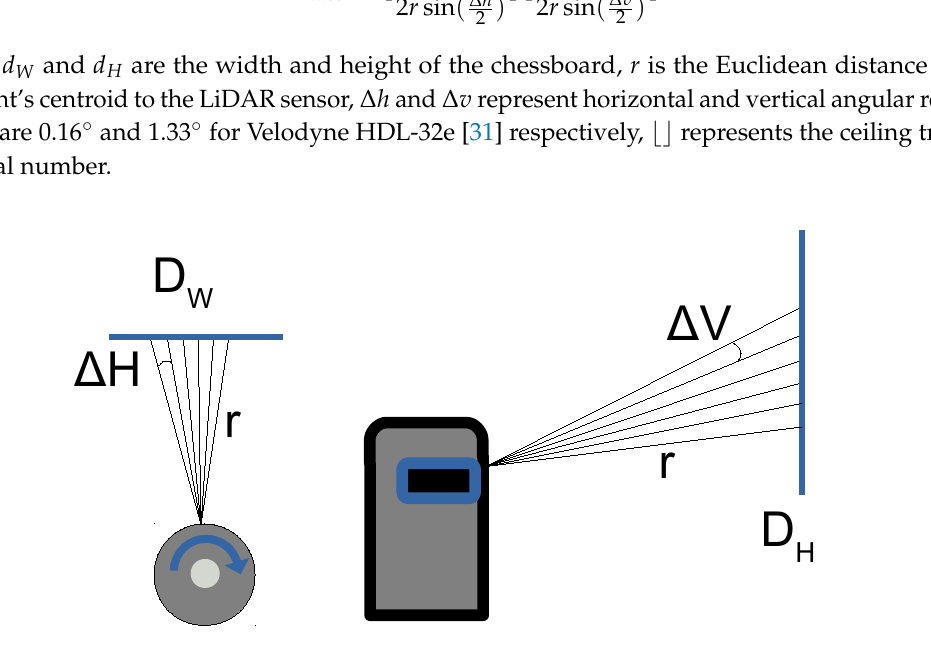
Figure 3. Angular resolution of the used LiDAR in this work. The left figure is the top view and the right one is the side view of the LiDAR and the